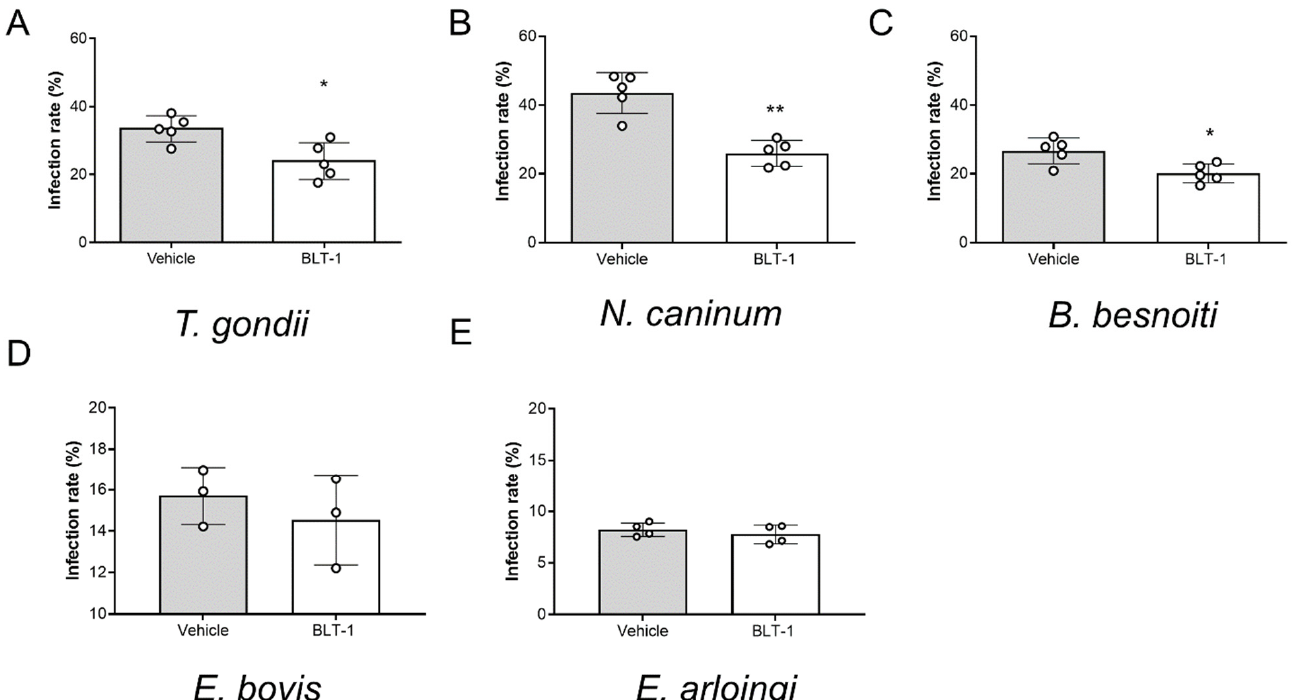
Figure 4. Impairment of T. gondii , N. caninum and B. besnoiti tachyzoite infectivity by BLT-1 treatments. Infection rates of the vehicle-treated or BLT1-treated T. gondii ( A ), N. caninum ( B ) and B. besnoiti ( C ) tachyzoites and the E. bovis ( D ) and E. arloingi ( E ) sporozoites. Bars represent the means of five biological replicates ± standard deviation; * p ≤ 0.05; ** p ≤ 0.01.